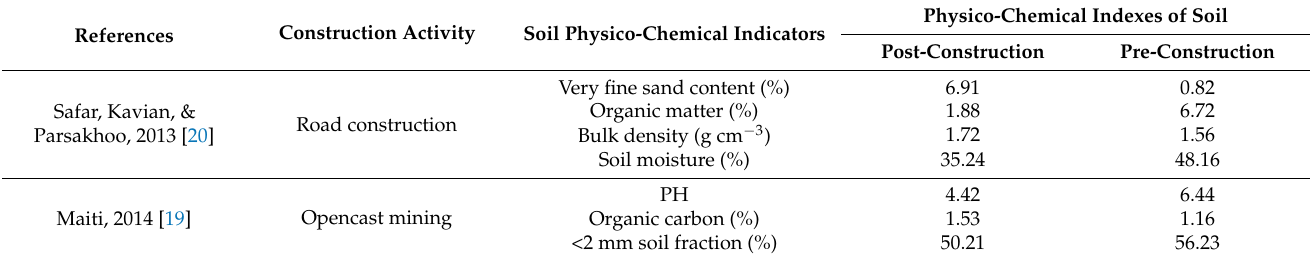
Table 2. Physico-chemical characteristics of site soil before and after